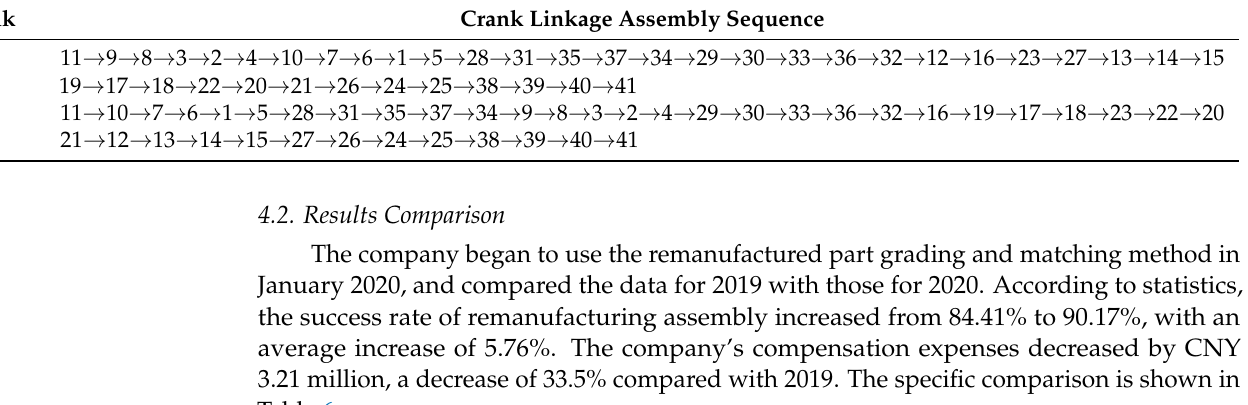
Table 5. Optimal assembly sequence.